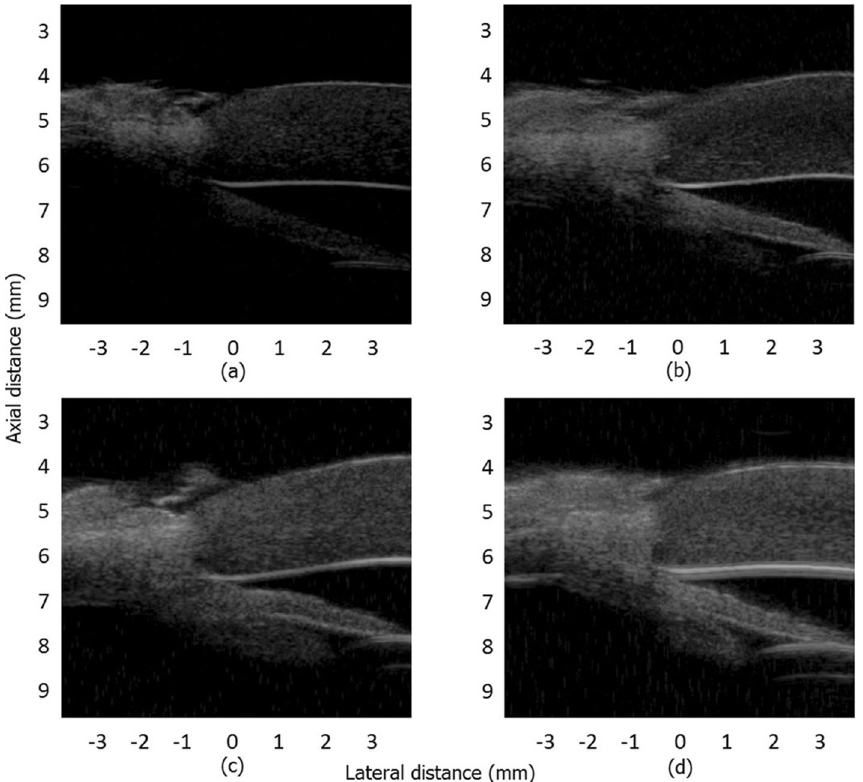
Figure 7. Imaging results of a corner segment of an in vitro porcine eyeball. ( a ) Real-time scan image using a single pulse. ( b – d ) Real-time imaging results using 4-bit, 8-bit, and 16-bit coded excitation and decoding compression, respectively.